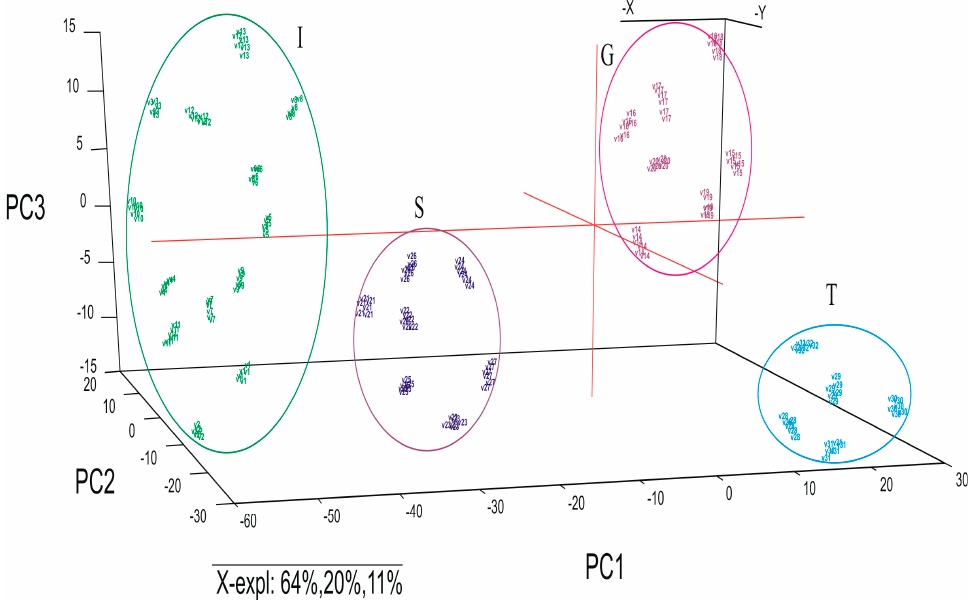
Figure 5. PCA scores plot corresponding to the CV data obtained with the sensors when these are exposed to EVOO samples from Italy, Spain, Greece and Tunisia.